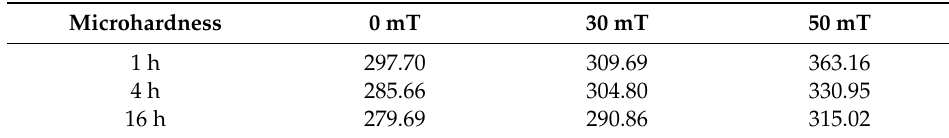
Table 11. The influence of the electromagnetic field on the microhardness of samples with di ff erent aging